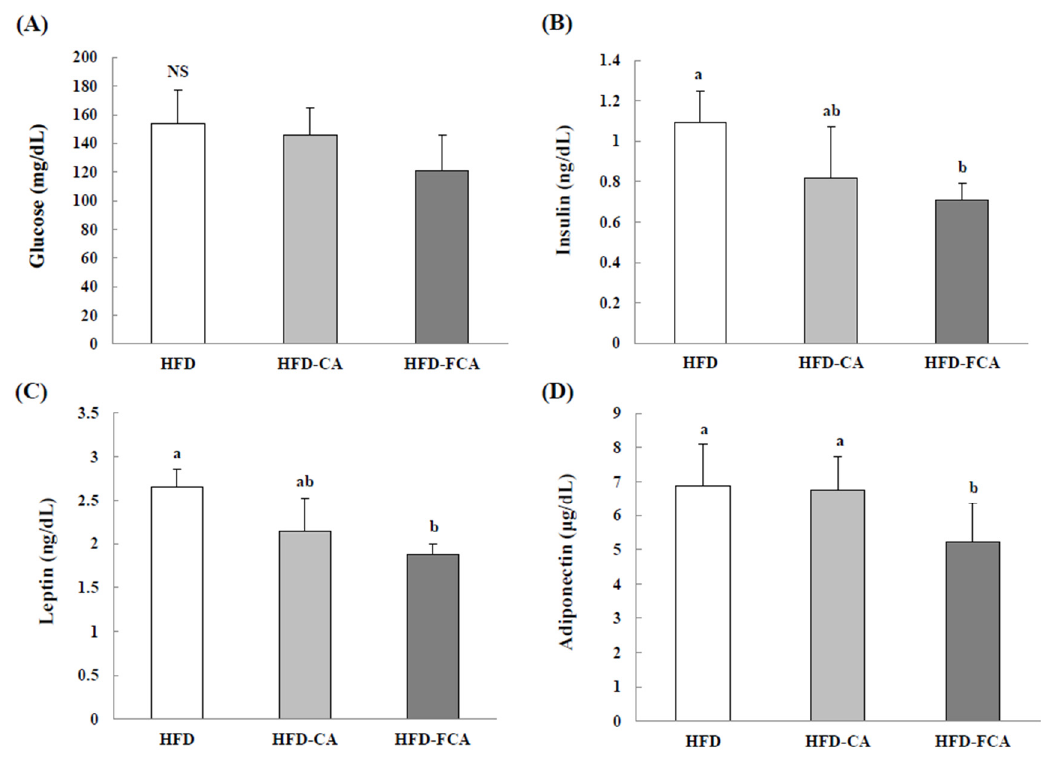
Figure 3. Glucose ( A ), insulin ( B ), leptin ( C ), and adiponectin ( D ) levels in serum of rats fed experimental diets for eight weeks. Values are mean ± SE ( n = 8). a,b; Bars with di ff erent letters are significantly di ff erent at p < 0.05 by Tukey’s test. NS: No significance. Diet groups; HFD, high fat diet group: HFD-CA, HFD + cabbage-apple juice administration group: HFD-FCA, HFD + fermented cabbage-apple juice administration